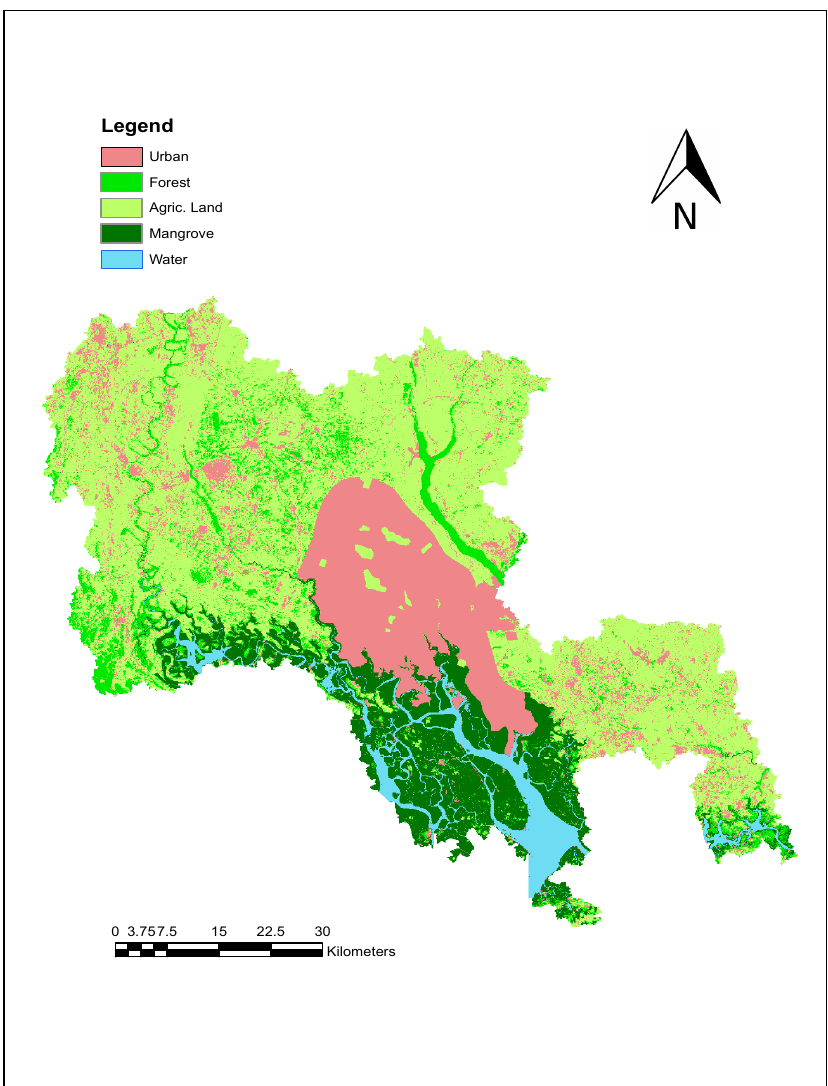
Figure 7. Map showing the extent of urban area on the 2003 base map. The superimposed 2060 data are based on the GPH Urban Master Plan. LULC classes include Urban Area, Forest, Agricultural Land, Mangrove, and Water. The 2060 Urban Master Plan was sourced from the Greater Port Harcourt Development Authority (GPHDA, 2010).